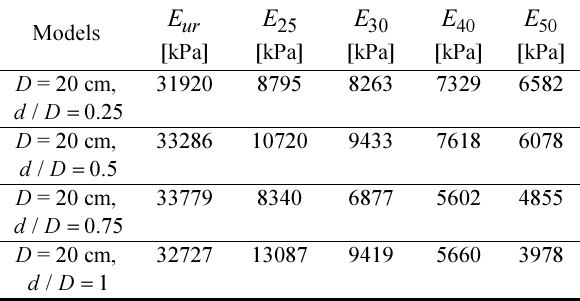
Table 5. E -moduli calculated from experiments using 20-cm bucket foundations